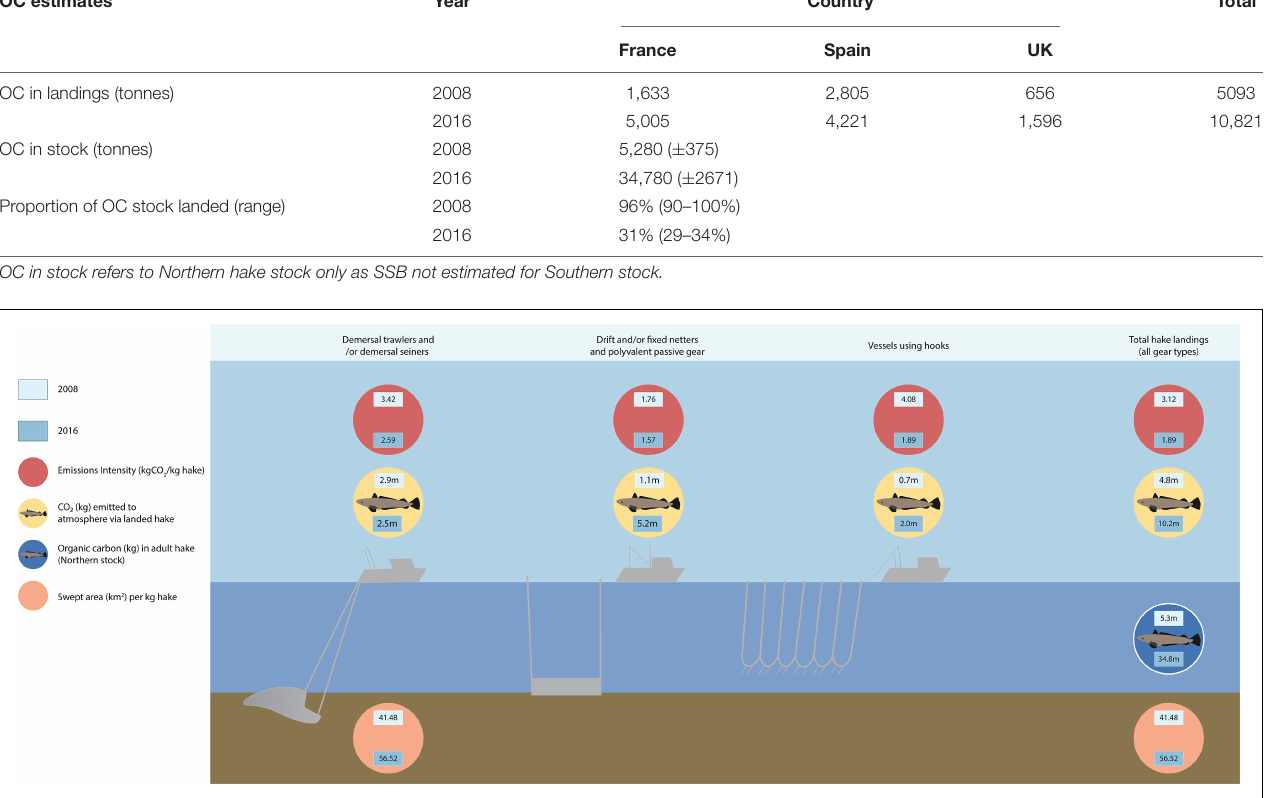
FIGURE 5 | Conceptual diagram of emissions and OC impacts by segment (demersal trawlers and/or demersal seiners; drift and fixed net gear types, including polyvalent gears; and vessels using hooks), and for total (all gear types) for 2008 and